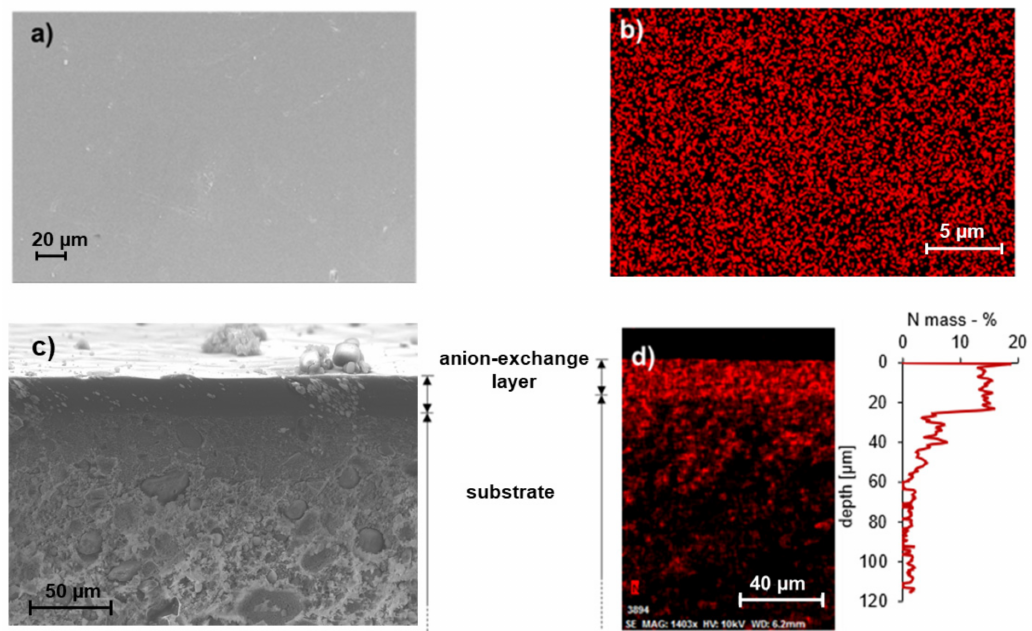
Figure 2. SEM/EDS micrographs presenting the structure of the composite AEM (PVP_8%). ( a ) anion exchange coating surface microscopy highlighting the coating continuity, the uniformity in the N distribution is proven by the surface EDS map ( b ), ( c ) cross section microscopy showing the hierarchical structure of the membrane: the ion exchange coating can be identified as the darker layer on top of the porous substrate, ( d ) cross section N EDS map and line scan confirming limited penetration of the anion exchange coating formulation in the porous